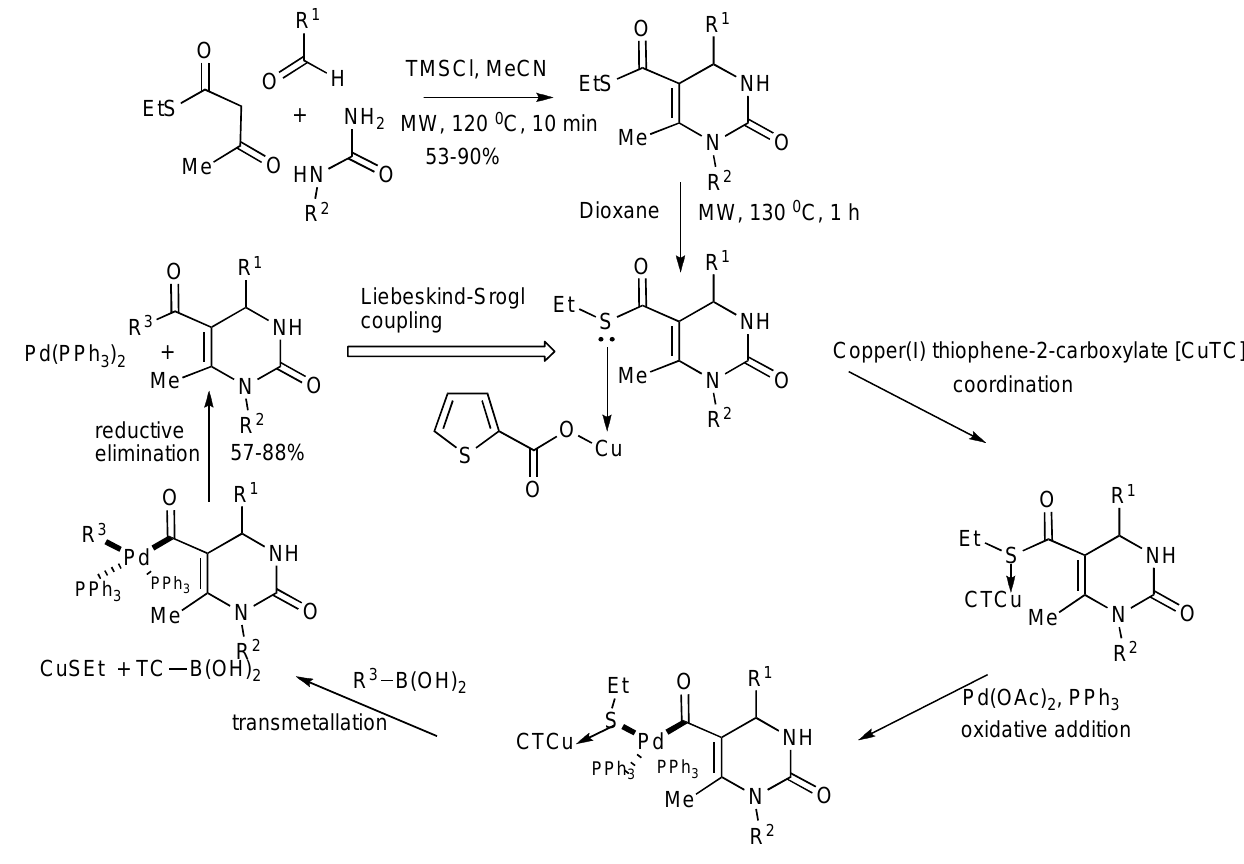
Scheme 7. Generation of 5-aroyl-3,4-dihydropyrimidin-2-one library from Biginelli and Liebeskind-Srogl coupling